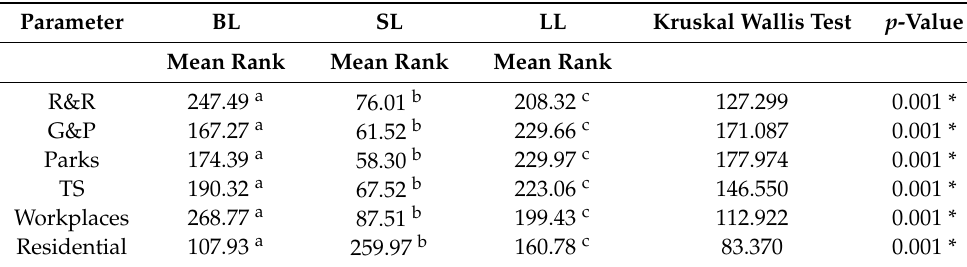
Table 5. Kruskal–Wallis test and Wilcoxon statistics for Pakistan in the period of February 2020–